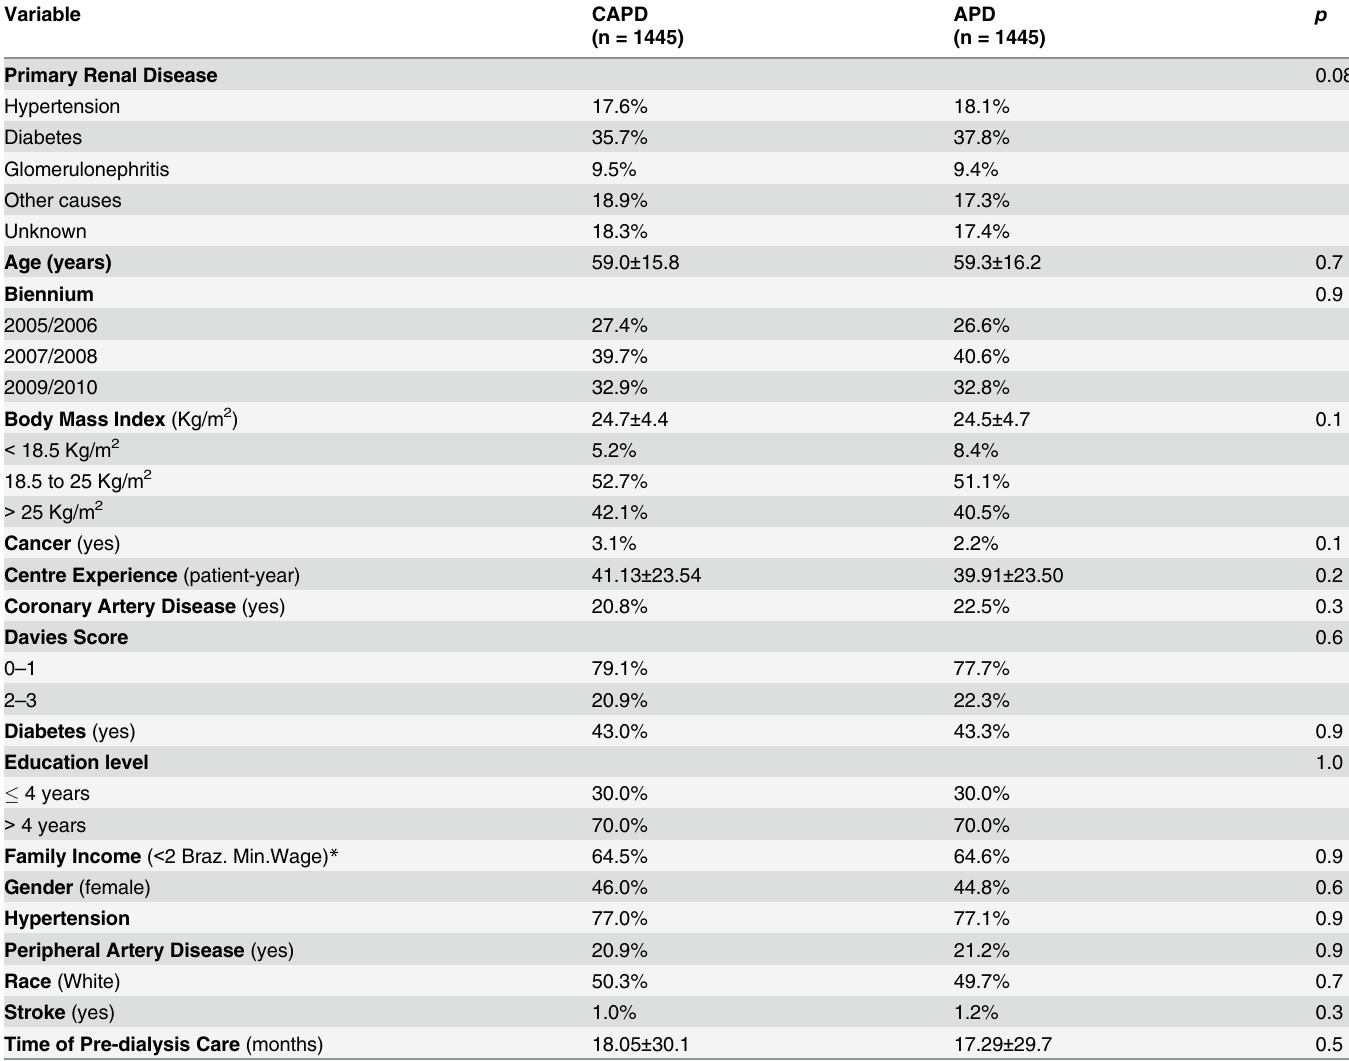
Table 1. Clinical and demographic characteristics of matched patients